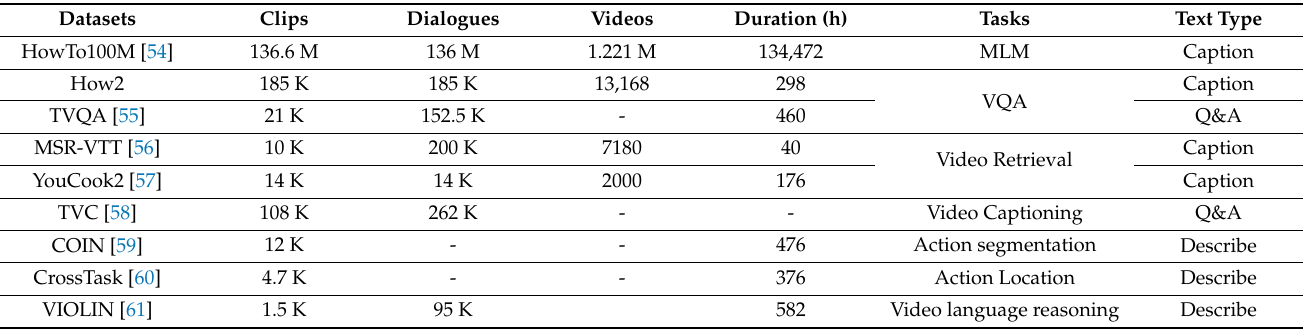
Table 10. Common datasets for video–language